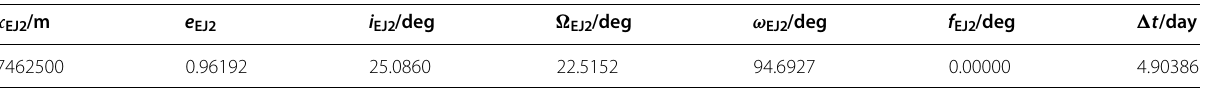
Table 3 The Earth‑centered modified classical orbital elements computed by the retrograde semi‑analytical model at TLI epoch κ EJ2 /m